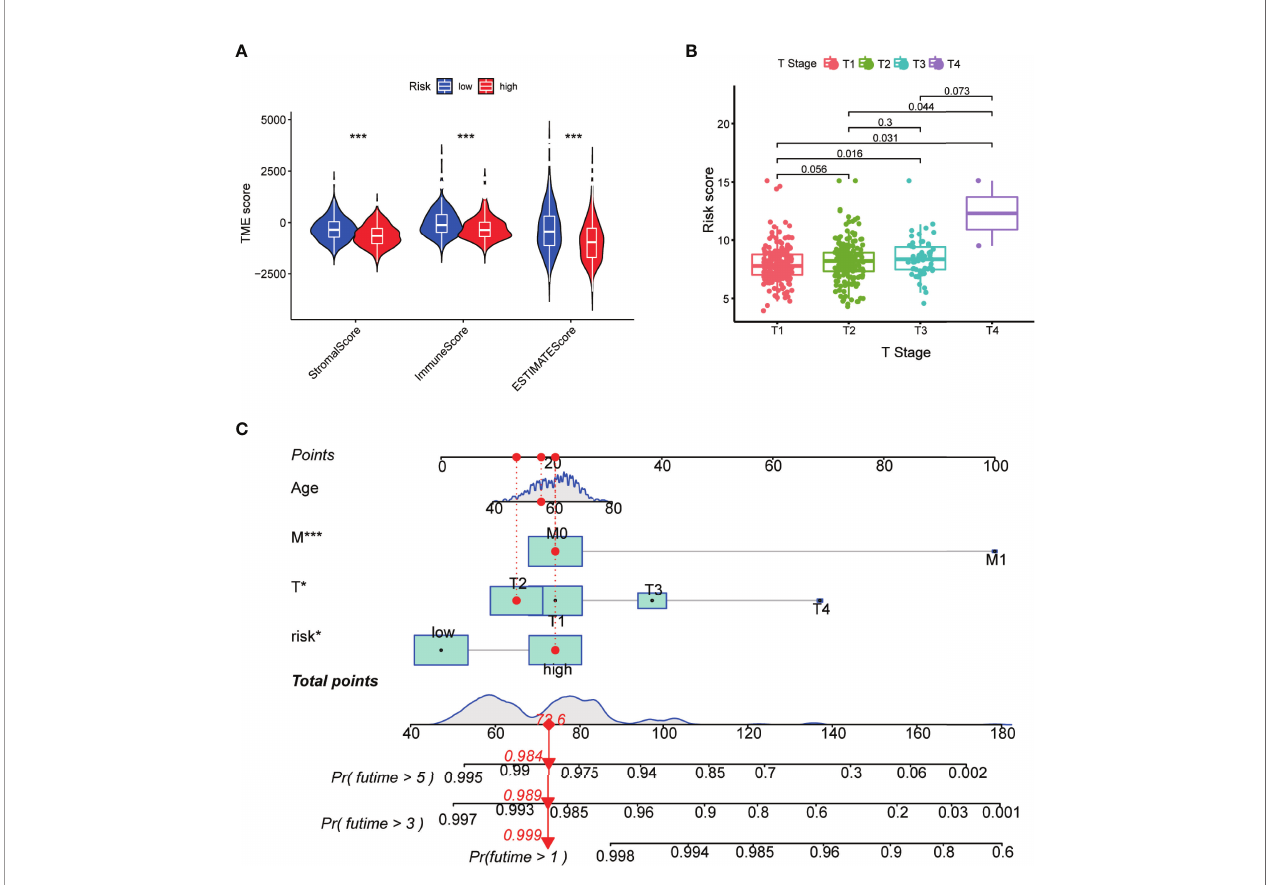
FIGURE 4 | Correlation of the m5C prognostic model with TME and clinical features. (A) Correlation between risk score and TME scores including stromal, immune, and ESTIMATE scores. (B) Risk scores of the PCa patients are classi fi ed by the T stage. (C) Nomogram consisting of the risk score and clinical characteristics to predict the overall survival in the PCa patients. P -values were shown as * P < 0.05 and *** P <